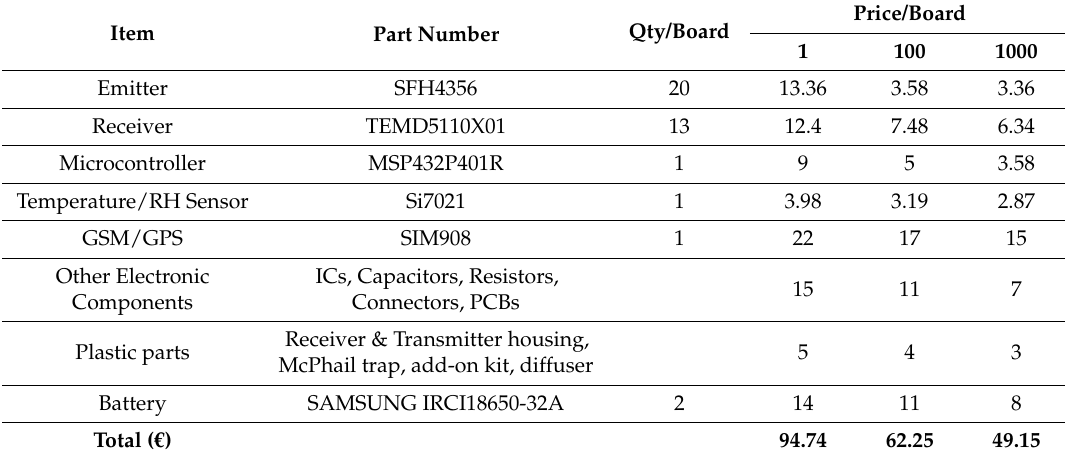
Table A1. Cost breakdown as per 10 September 2016 in